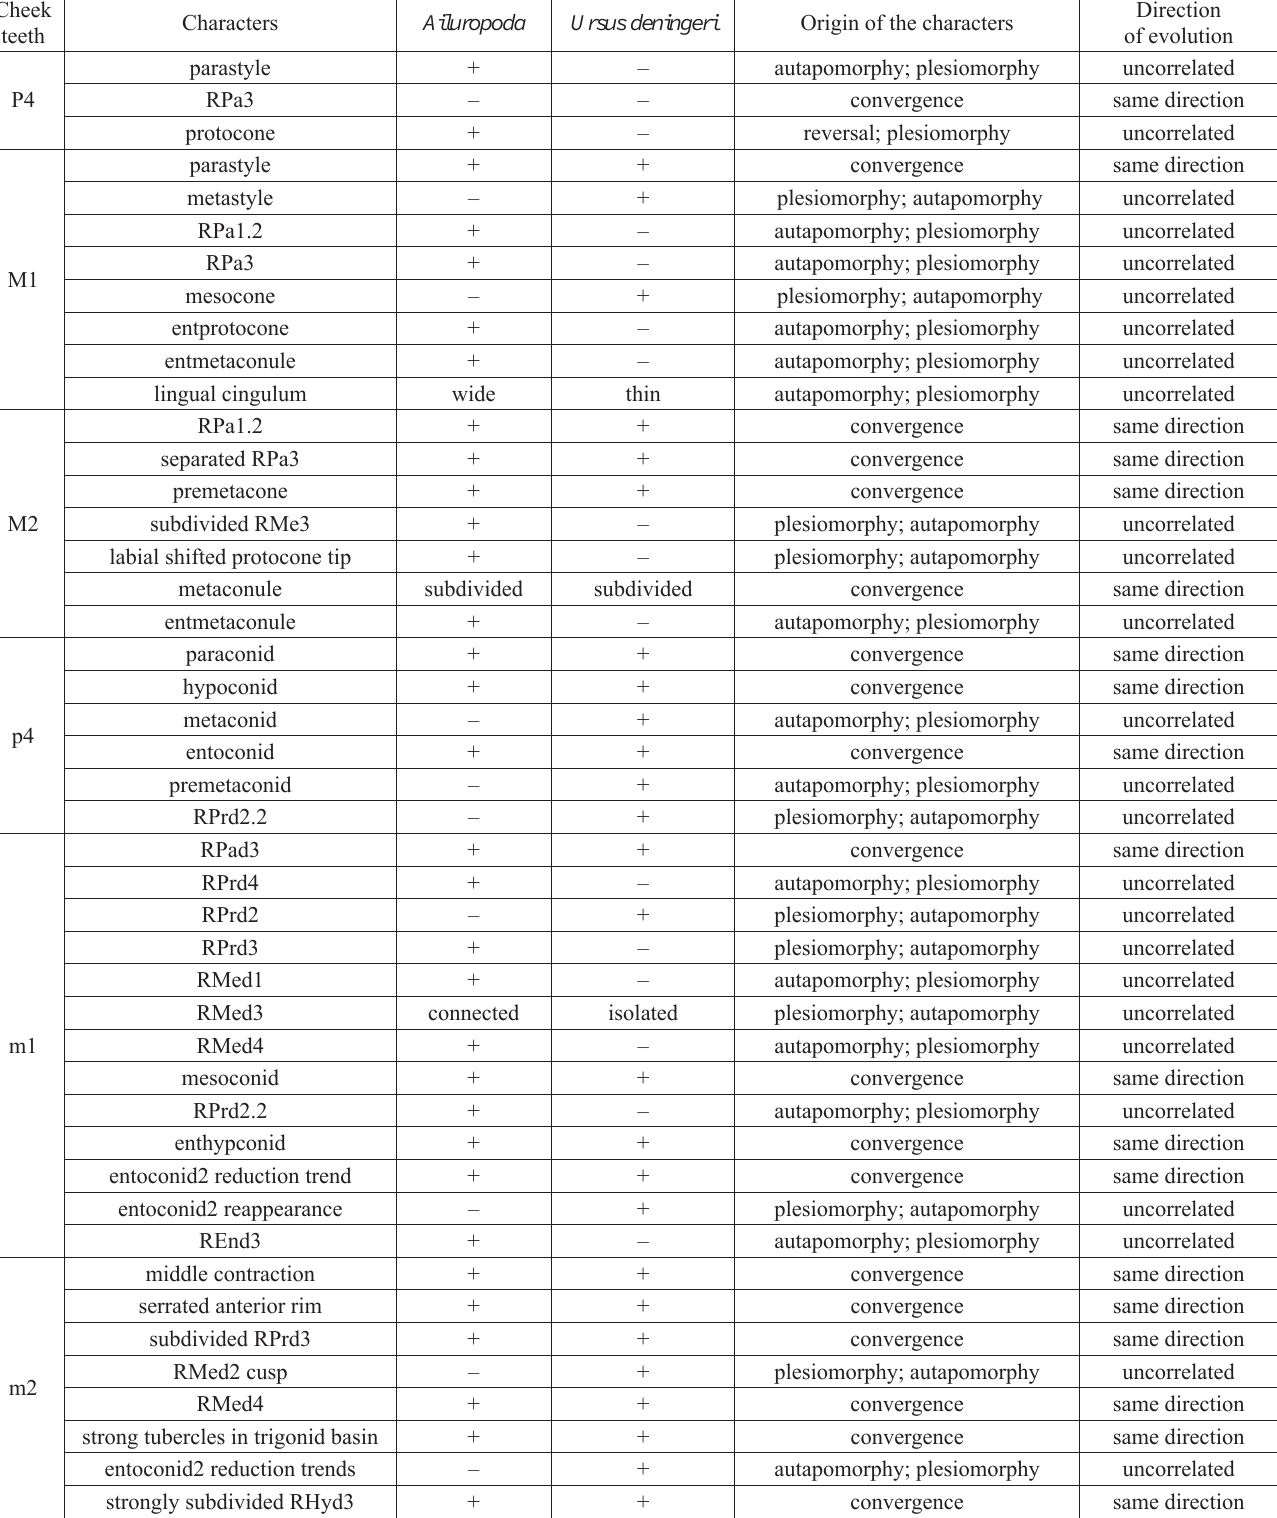
Table 1. Summary and evaluation of morphology of Ailuropoda and Ursus deningeri . Abbreviations: +, present; –, absent; REnd3, medial ridge of entoconid; RHyd3, medial ridge of protoconid; RMed1, anterior ridge of metaconid; RMed2, posterior ridge of metaconid; RMe3/RMed3, medial ridge of metacone/metaconid; RMed4, postero-medial ridge of metaconid; RPa1.2, medial branch of anterior ridge of paracone; RPa3/ RPad3, medial ridge of paracone/paraconid; RPrd2, posterior ridge of protoconid; RPrd2.2, medial branch of the posterior ridge of protoconid; RPrd3, postero-medial ridge of protoconid; RPrd4, postero-lateral ridge of